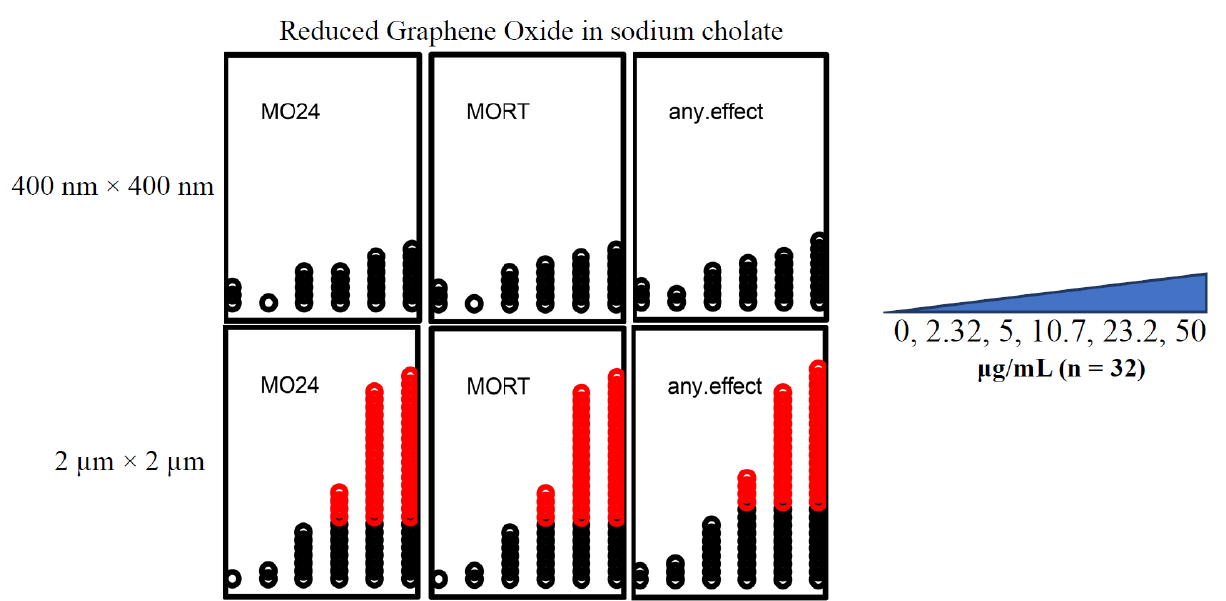
Figure 3. rGO developmental toxicity. rGO exposures of embryos ( n = 32) revealed that the 400 nm × 400 nm rGO did not cause significant mortality at any of the concentrations investigated (0 μ g/mL, 2.32 μ g/mL, 5 μ g/mL, 10.7 μ g/mL, 23.2 μ g/mL, 50 μ g/mL) ( p > 0.05). The 2 μm × 2 μm rGO exposures caused mortality and malformations starting at 10.7 μ g/mL. MO24 = 24 hpf mortality; MORT = 120 hpf mortality; any.effect = physical malformations, including mortality at 120 hpf. Outcomes significantly above the binomial threshold (Student’s t -test; α = 0.05) are indicated in red on the dot plot.